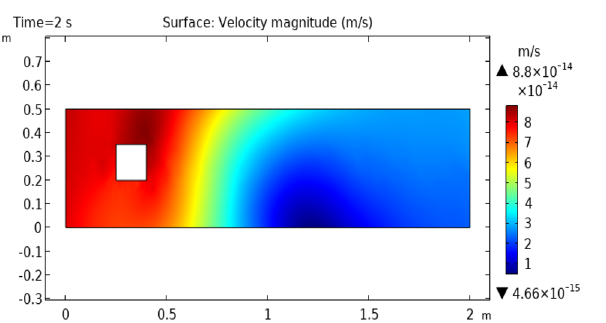
Figure 4. Velocity distribution in squared cylindrical flow at t = 2 s.